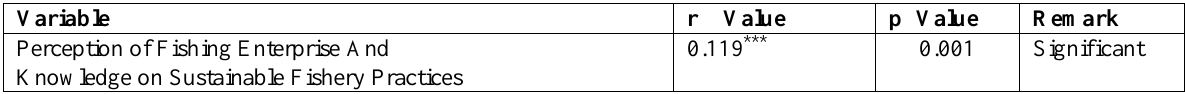
Table 4. The result of Pearson Product Moment Correlation between the Perception of fishing enterprise and knowledge on sustainable fishery practices